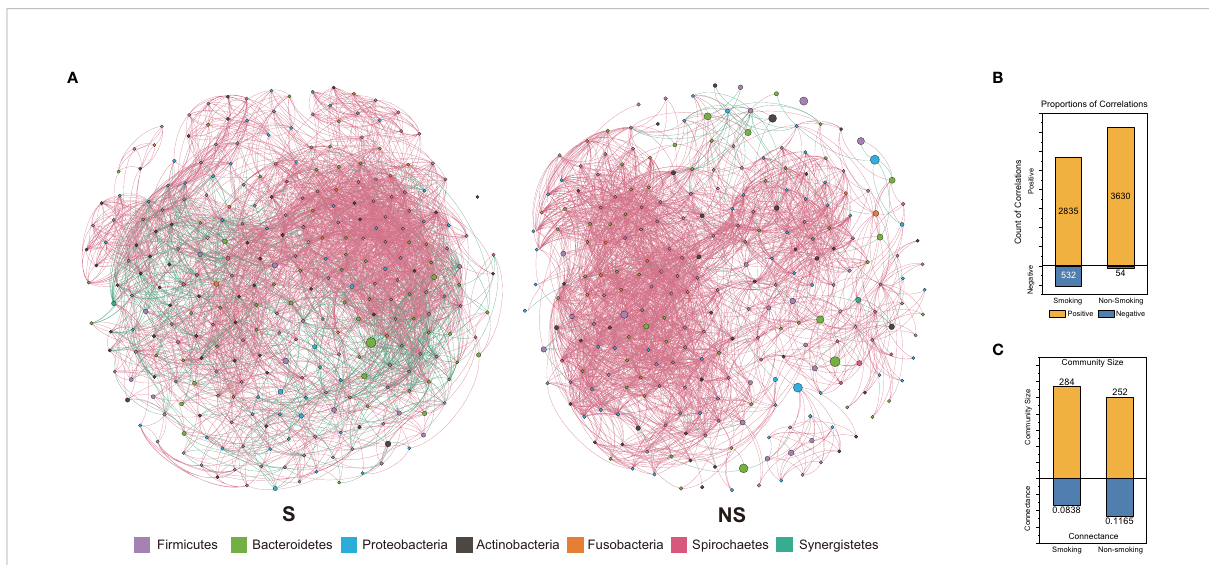
FIGURE 2 (A) Bacterial co-occurrence networks of smoking and nonsmoking groups. Each node in the network represents a bacterial species. The colour of the node indicates the phylum of the species, while the size re fl ects its abundance. Edges linking nodes represent established correlations- between species. Red edges represent positive correlations, while green edges represent negative correlations. (B) Bar charts showing the count and proportion of positive/negative correlations in the smoking and nonsmoking groups. (C) Bar charts showing the community size and total connectance in the smoking and nonsmoking